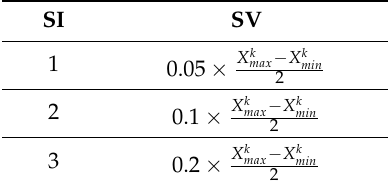
Table 7. Shift Index (SI) and Shift Value (SV)